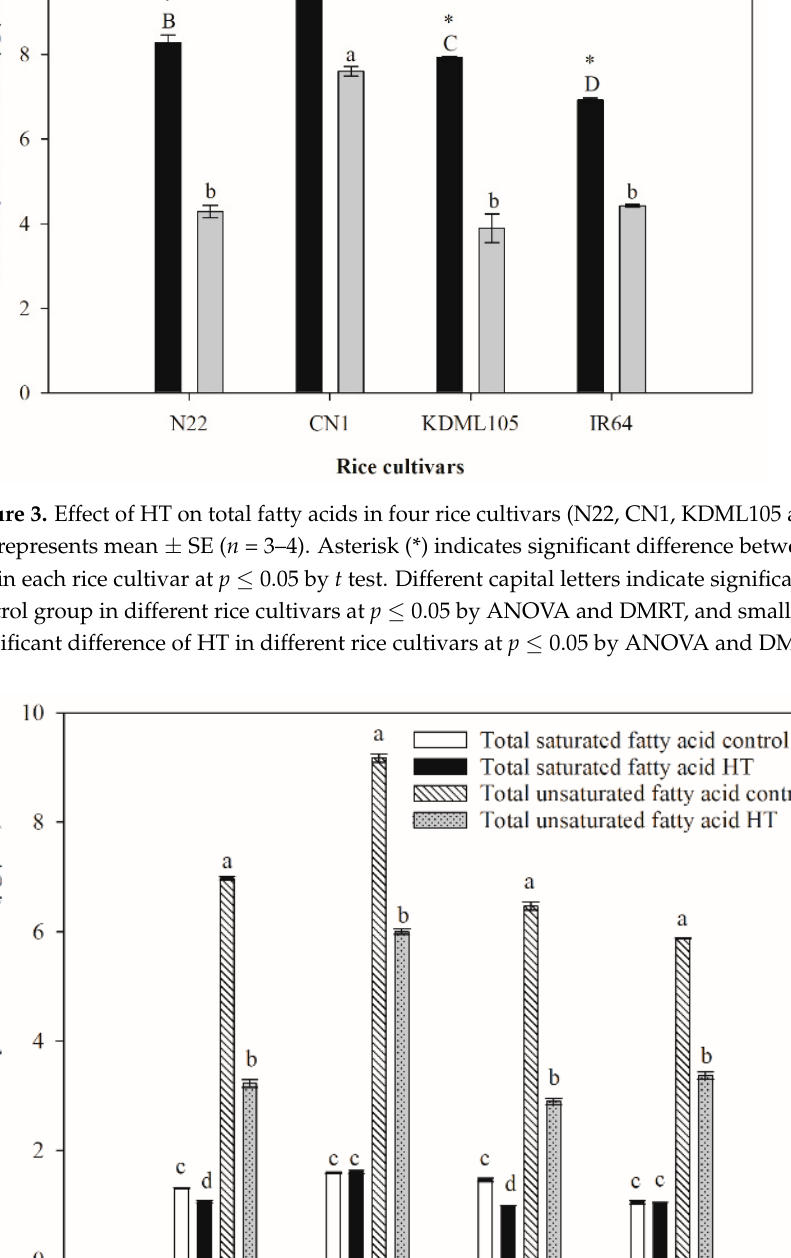
Figure 4. Effect of HT on total saturated and total unsaturated fatty acids in four rice cultivars (N22, CN1, KDML105 and IR64). Each bar represents mean ± SE ( n = 3–4), and different small letters indicate significant difference in each rice cultivar at p ≤ 0.05 by ANOVA and